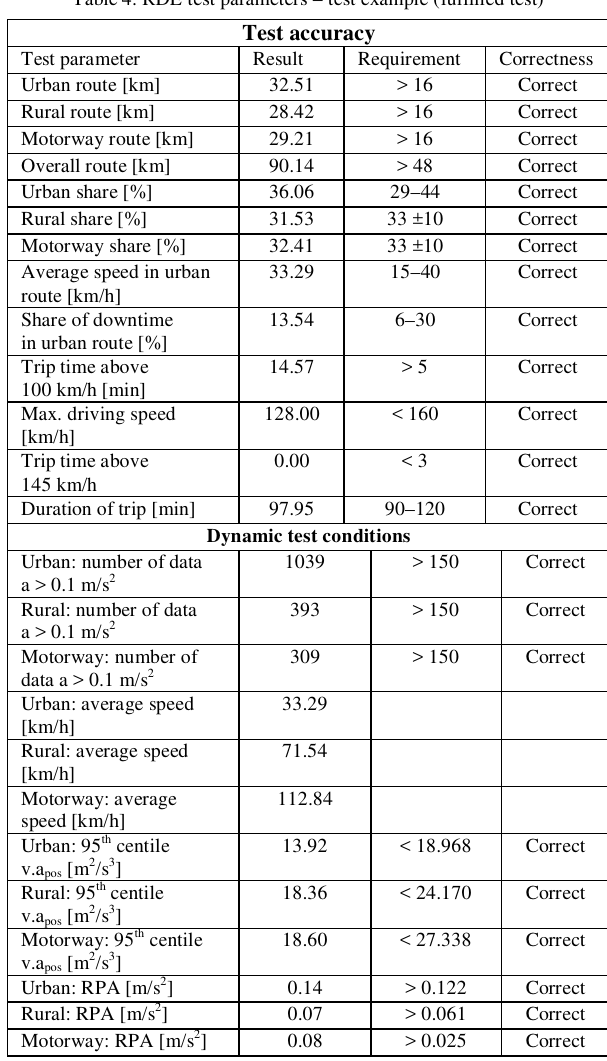
Table 3. RDE test parameters – test example (unfulfilled test) Table 4. RDE test parameters – test example (fulfilled test)